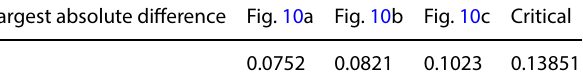
Fig. 13 Histograms of output displacement in m or failure load in KPa and the normal distribution fitting for three randomly selected analyses. a Porous analyses with constant distribution for 𝜅 , ran- dom distribution for c and Karhunen–Loeve Random Field for k with correlation b = 75 m depth h = 20 m and monitored output